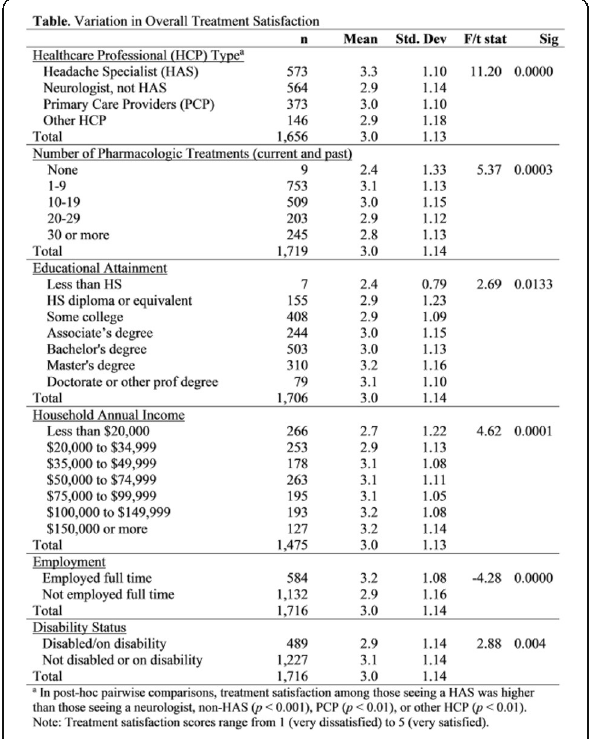
Table 1 (abstract P0219). See text for description